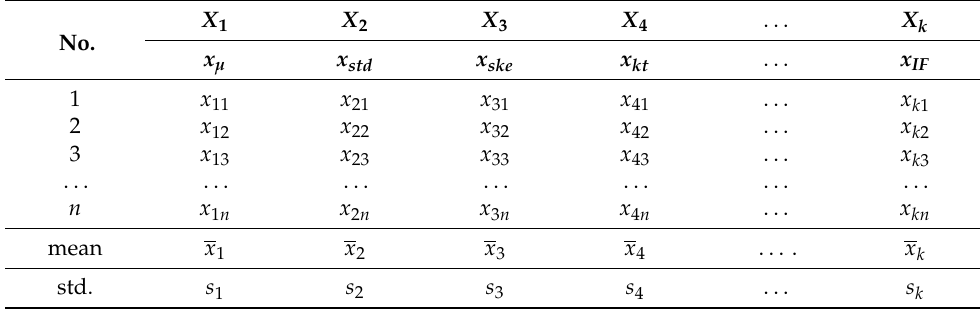
Table 3. Data schema of normal